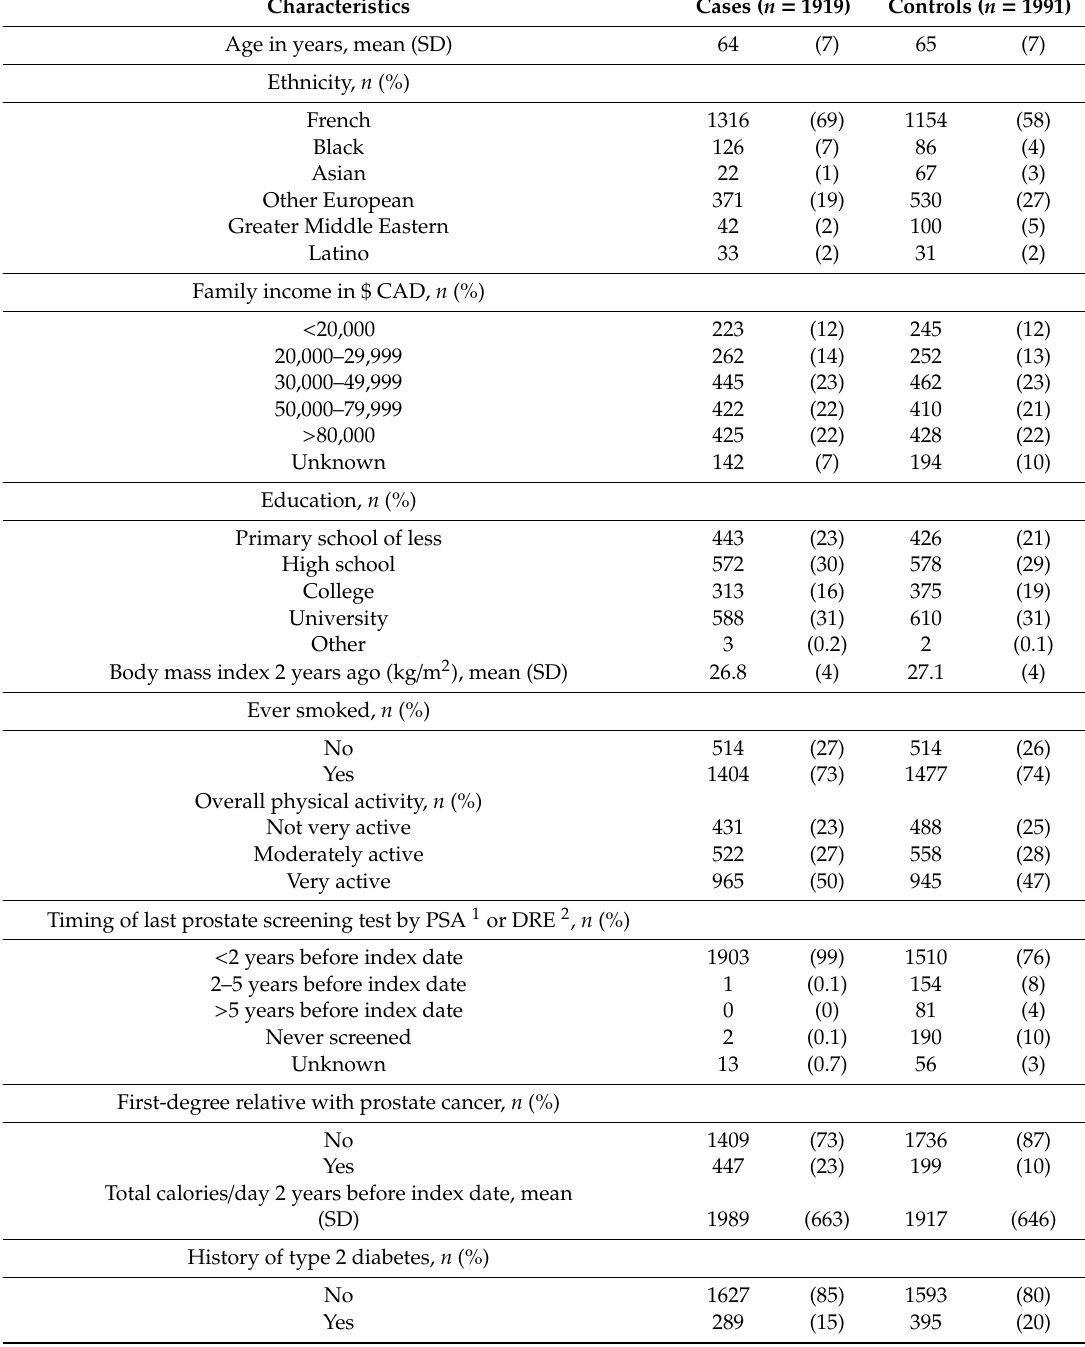
Table 2. Selected characteristics of cases and controls participating in PROtEuS, Montreal, Canada (2005–2012).